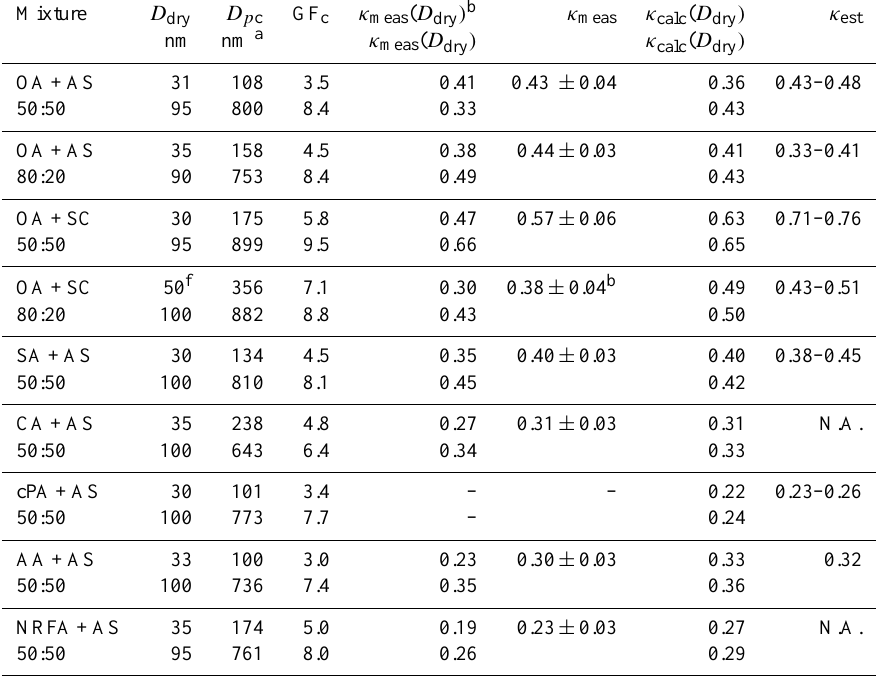
Table 7. Droplet diameter ( D p c ) and growth factor (GF c ) at activation for two different dry sizes ( D dry ) as well as measured κ values ( κ meas ( D dry ) , determined from experimental data listed in Table 6 at the two dry particle diameters listed in the second column, D dry , and κ meas , determined as the average of all κ values calculated from each of the activation experiments listed in Table 6), calculated κ values ( κ calc , calculated according to Eq. (7), determining i using Eqs. (4) and (5) at the growth factors listed in the fourth column, GF c ) and estimated κ values ( κ est , estimated by applying Eq. (8) to the κ lit values listed in Table 5). Mixture D dry D p c GF